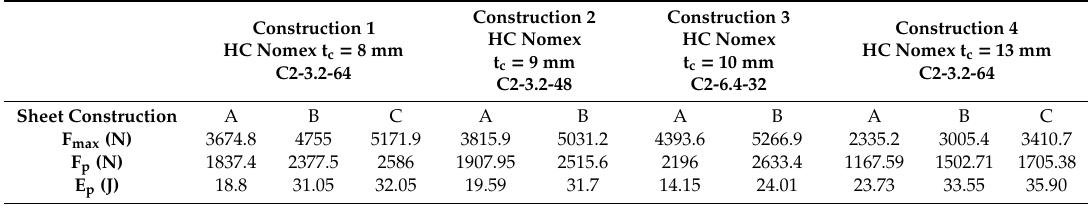
Table 5. Results of impact testing with di ff erent types of core material Nomex.